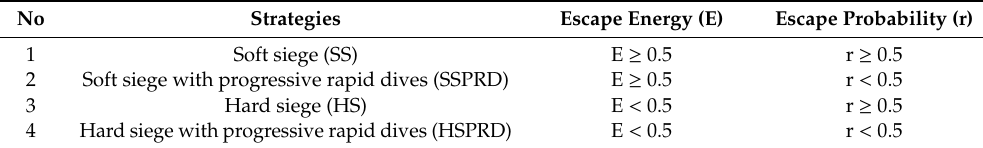
Table 1. Hunting strategies of Harris hawks during exploitation